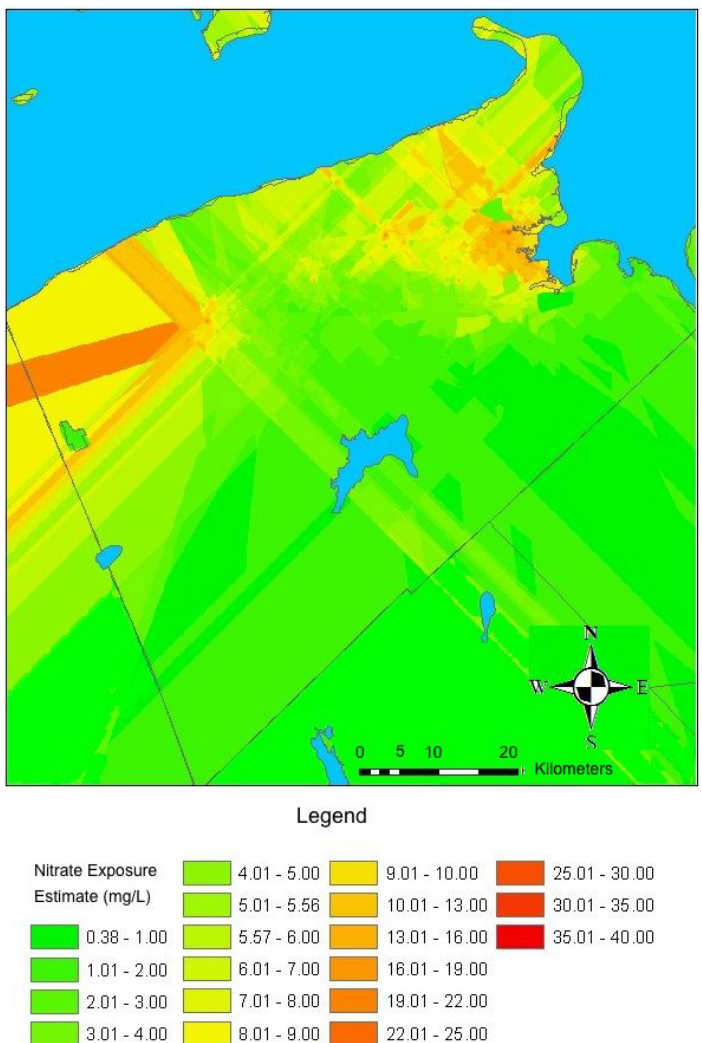
Figure 2. Map showing the drinking-water nitrate exposure estimates for Kings County, Nova Scotia, that were derived using ordinary kriging and extrapolation estimates in rural areas and statistically derived estimates of average nitrate concentrations in municipal water supplied